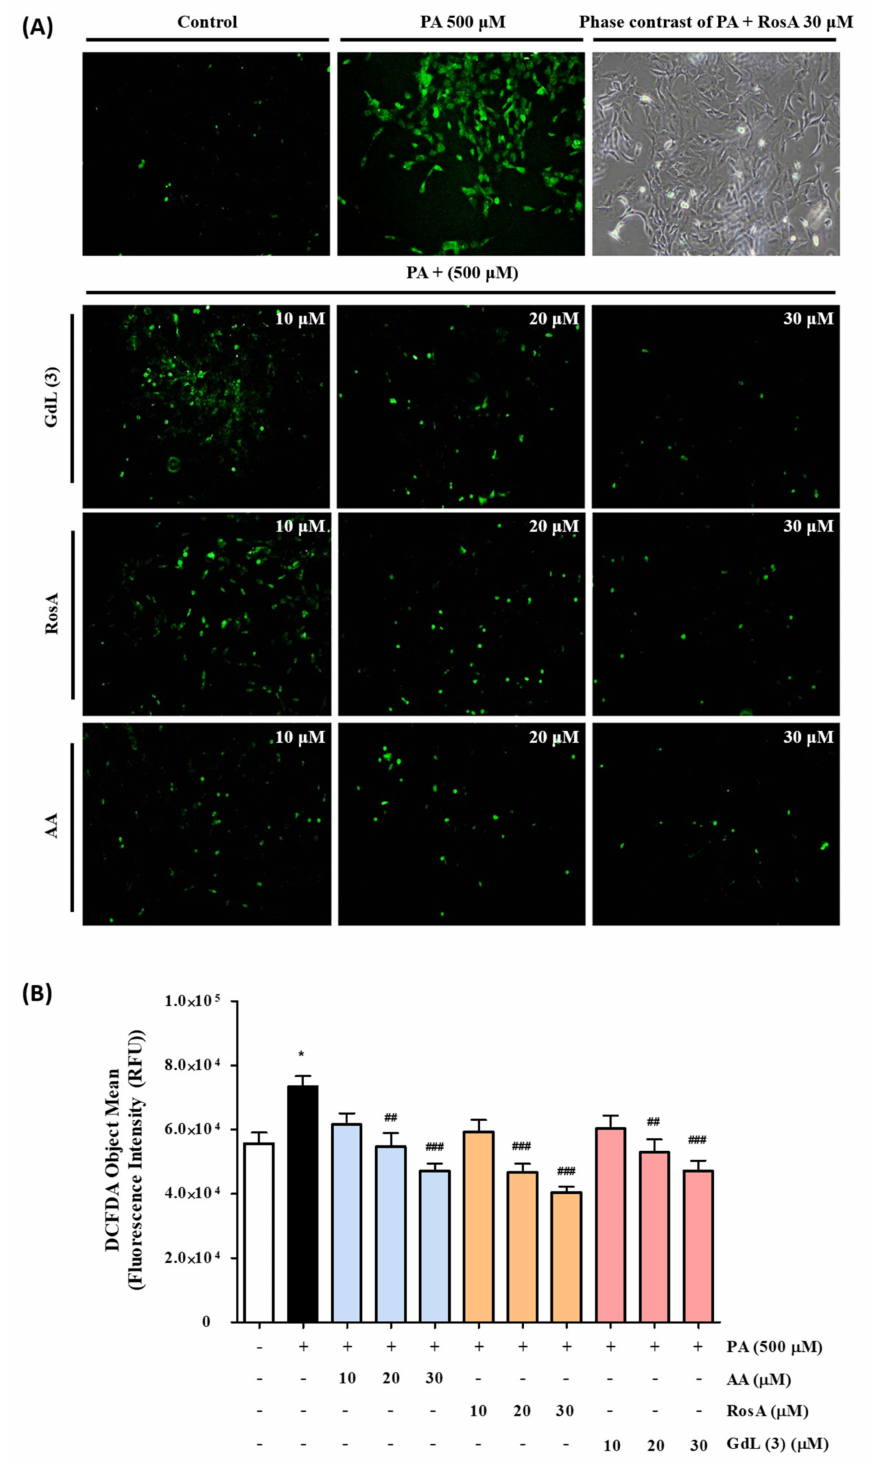
Figure 5. Determination of cellular palmitic acid (PA)-induced reactive oxygen species (ROS) by the DCF-DA assay. ( A ) Fluorescence microscopic images of the control and AA, RosA, and GdL (3) treatments. ( B ) DCF-DA object mean (fluorescence intensity) of PA-induced ROS. * p < 0.05, significant di ff erence from the control. ## p < 0.01 and ### p < 0.001, significant di ff erence from PA (n = 3 per